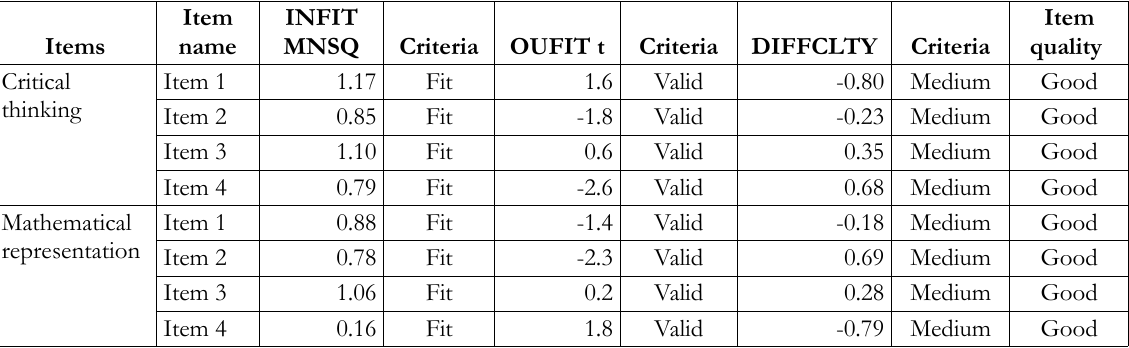
Table 6. Interpretation of test items